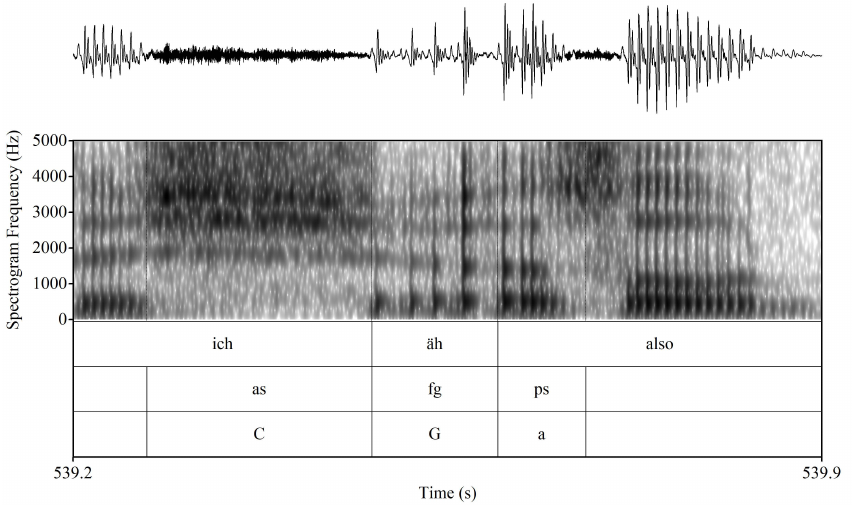
Figure 7. Example of glottal filler particle fg (112ms) being categorically different from the following [a] in the postsegment ps (source: